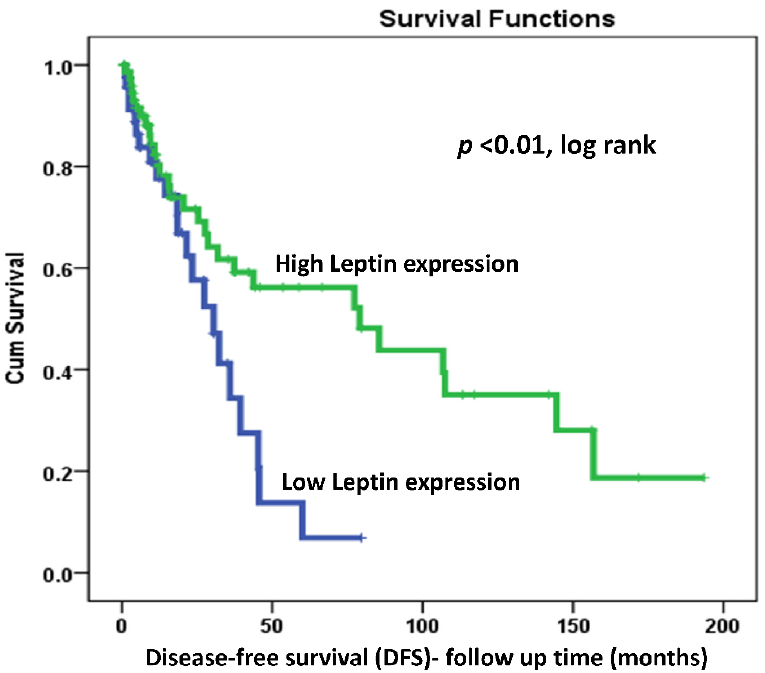
Figure 2. Kaplan – Meier analysis of the association between LEP protein expression pattern and Disease-Free-survival (DFS) in OC patients using (low vs. high expression as a discriminator ( p = 0.01, log-rank).